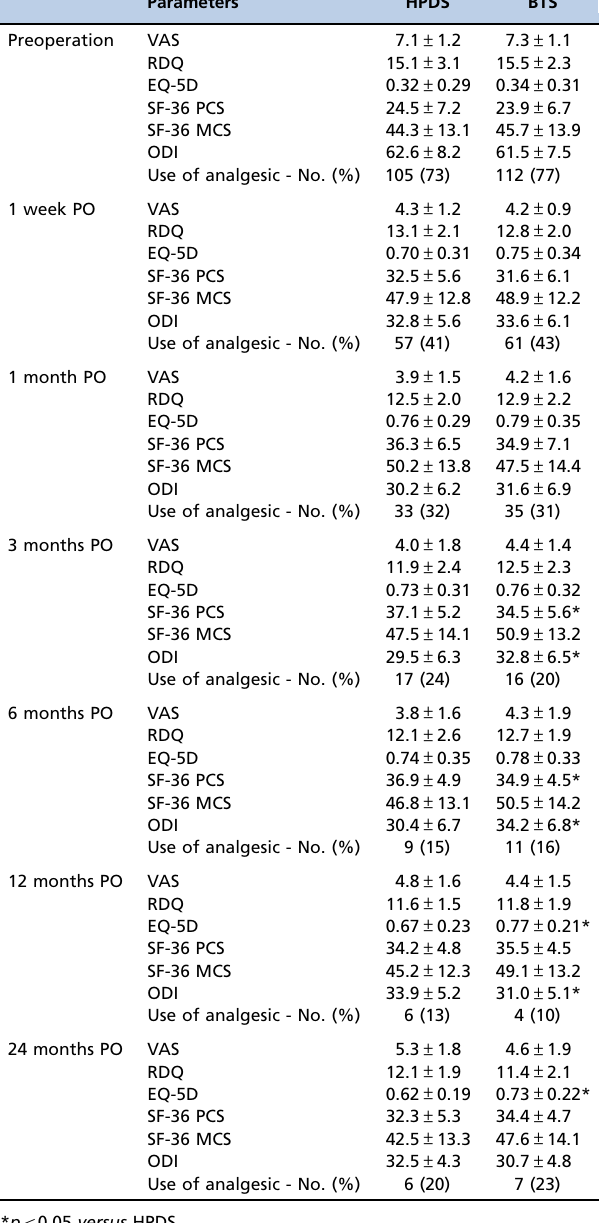
Table 3 - Clinical assessments (mean ±